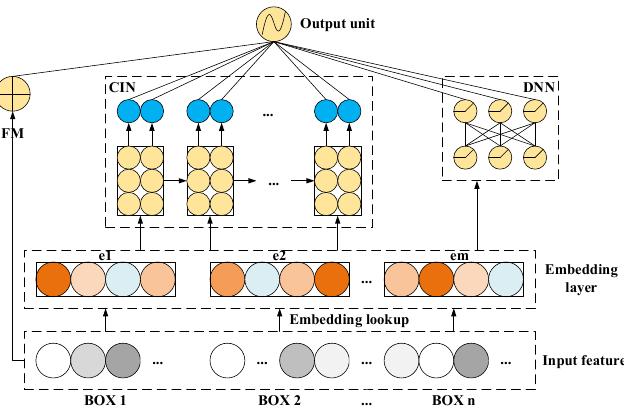
Figure 6. The structure of the xDeepFM model.